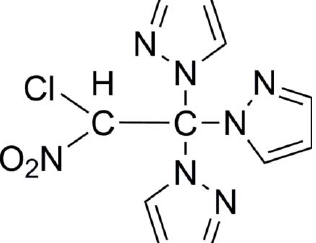
Figure 1 Structure diagram of the starting material 1-chloro-1-nitro-2,2,2-tris-